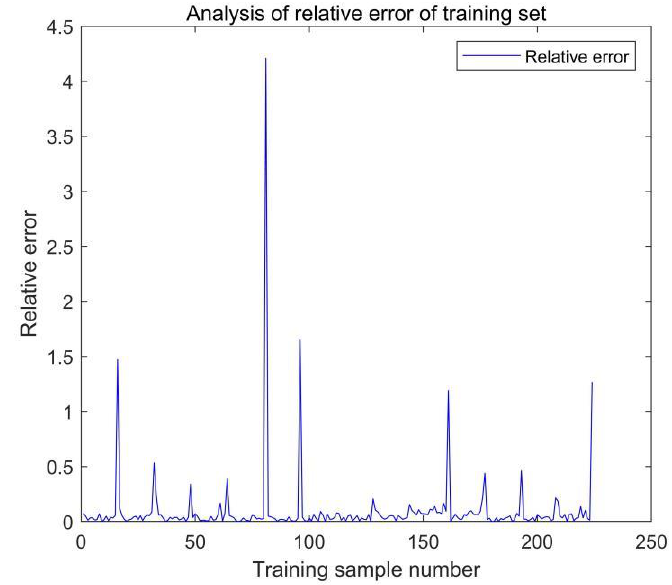
Figure 20. Relative error plot of the training set.